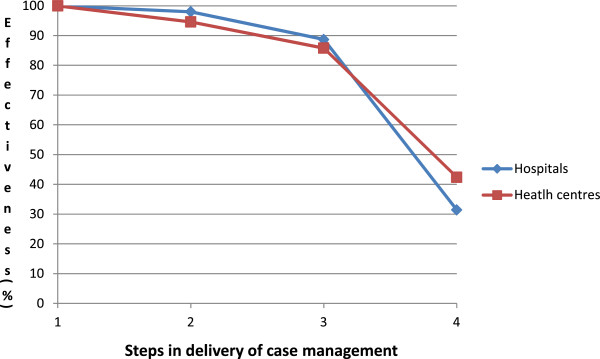
Health systems effectiveness of case management of malaria in febrile children <5 years. Note: Step 1 = Receive a clinical diagnosis or are malaria parasite positive (1065 hospitals, 839 health centres); Step 2 = Given any anti-malarial (1044/1065 hospitals, 794/839 health centres); Step 3 = Given an ACT or quinine (945/1044 hospitals, 720/794 health centres); Step 4 = Carer knows how to give ACT [number of days and number of times per day]. (334/888 hospitals, 356/692 health centres).